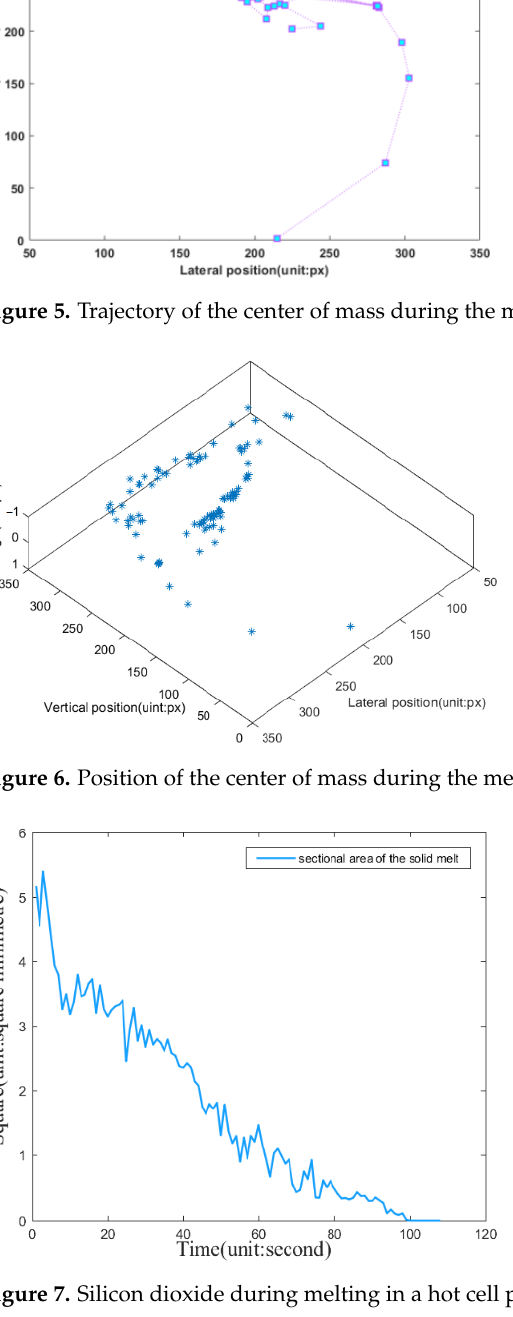
Figure 8. Silicon dioxide during melting in a hot cell change in circumference at each moment. 3.3. Theoretical Knowledge of the SFS Model SFS [24]: By extracting the physical data obtained from the edges, we obtain 2D data. To model the 3D data, we need to find the height value of each pixel point in the plane coordinate system to draw the 3D model. SFS is an algorithm that calculates height values by constructing a relationship between the light source and the image and calculating three important parameters — the inclination angle, the declination angle and the deriva- tive of the image grey scale. Using these three parameters we can calculate the predicted height value. Then, by plotting the calculations we obtain the final result. The flow of the calculation of the melting rate of silicon dioxide particles is shown in Figure 9.